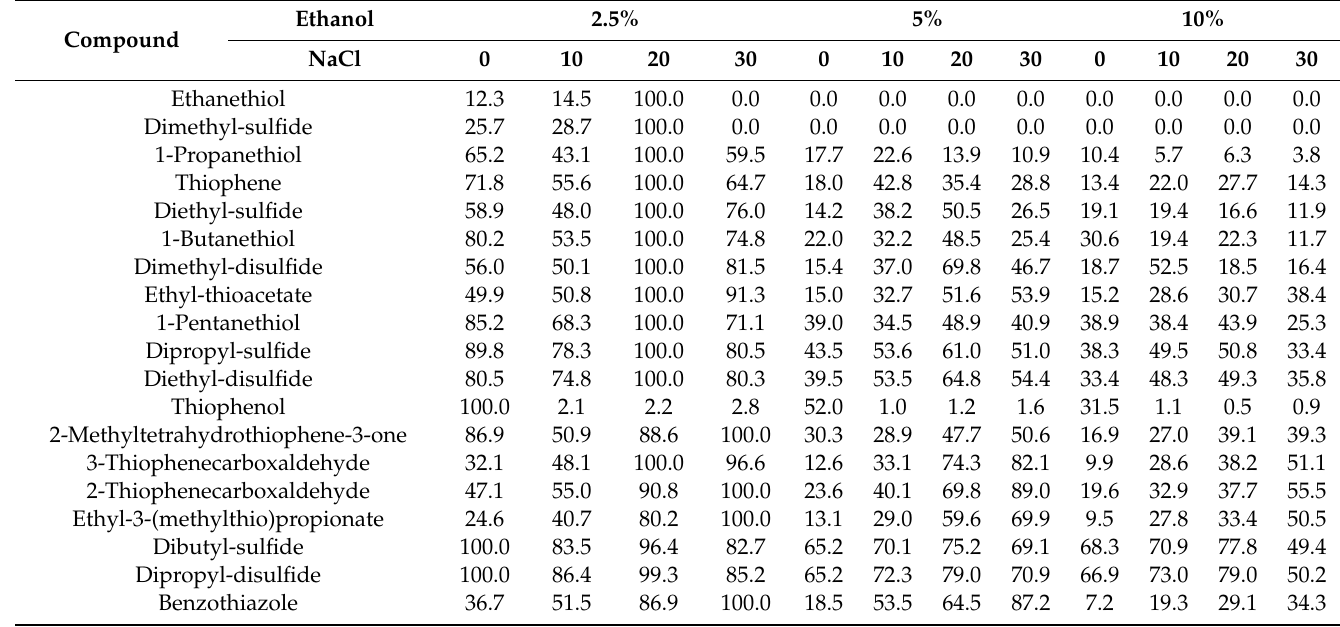
Table 1. The e ff ect of ethanol (% v / v ) and NaCl (% w / v ) concentration on the response of individual tested compounds. Data expressed as percent of maximum value obtained for each